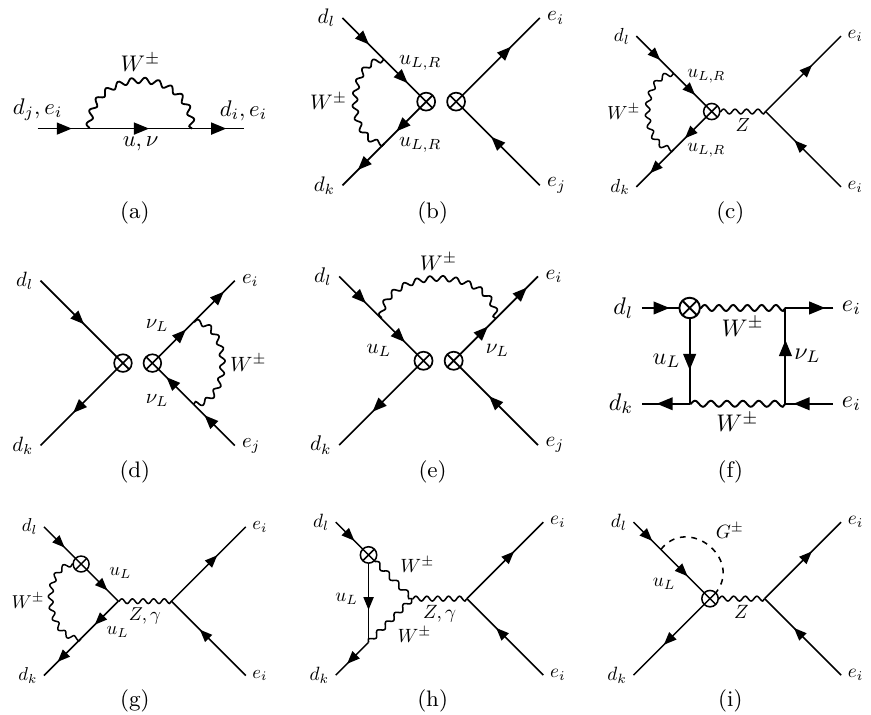
Figure 1 . Feynman diagrams for the EW one-loop corrections. Additionally, there are diagrams where the Nambu-Goldstone (NG) boson G ± , instead of W ± , is exchanged. The vertices with a cross in a circle indicate SMEFT operators. In (a), the vertices are provided either by the SMEFT or the SM. For (f–h), the SMEFT vertex can also be assigned to the lower quark line. Similarly, the NG boson can be attached to the lower quark instead of the upper one in